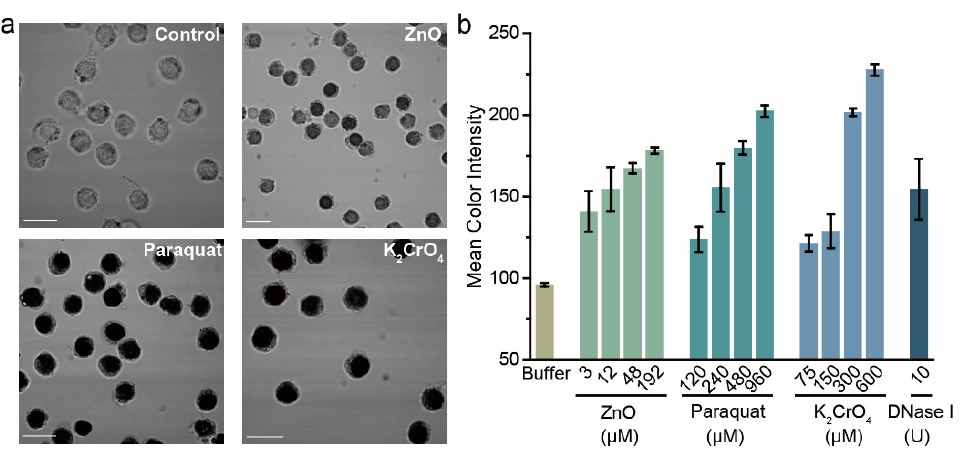
Figure 4. Genotoxicity evaluation of ZFL cells exposed to different environmental pollutants by ( a ) TUNEL assay and ( b ) PAD. Scale bar: 10 μ m. DNase I-treated cells were used as positive control. The error bars represent standard deviations of four independent experiments.